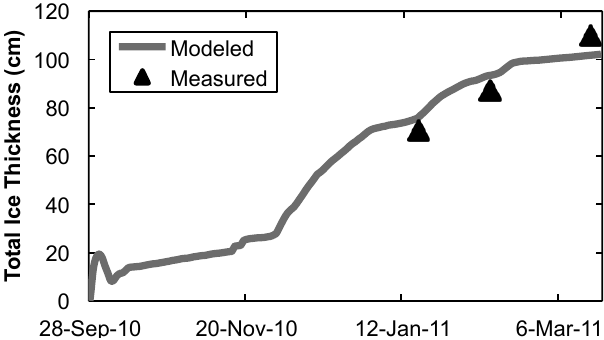
Figure 6. Modeled and measured total thicknesses of the ice layer (white and black ice) during the winter of 2010–2011. Measure- ments were obtained in areas where snow was occasionally com- pacted by foot traffic, an effect accounted for in the modeled thick- ness. A value of α = 0 . 94 was used in the ice growth model for this